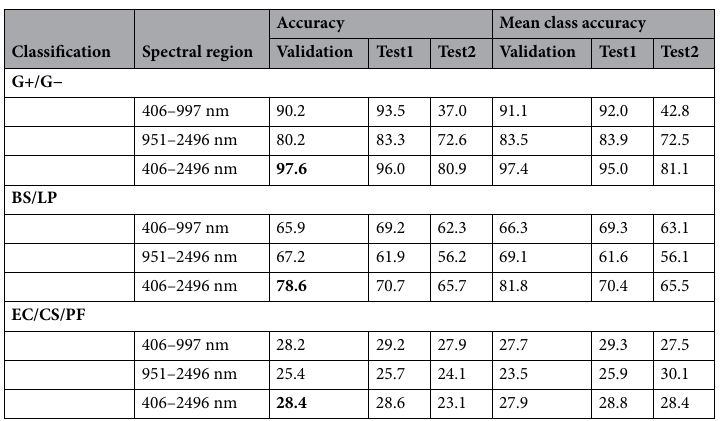
Table 8. Model performances for PCA-LSTM models. For each spectral region, the model yielding maximum accuracy in the validation set is bolded.